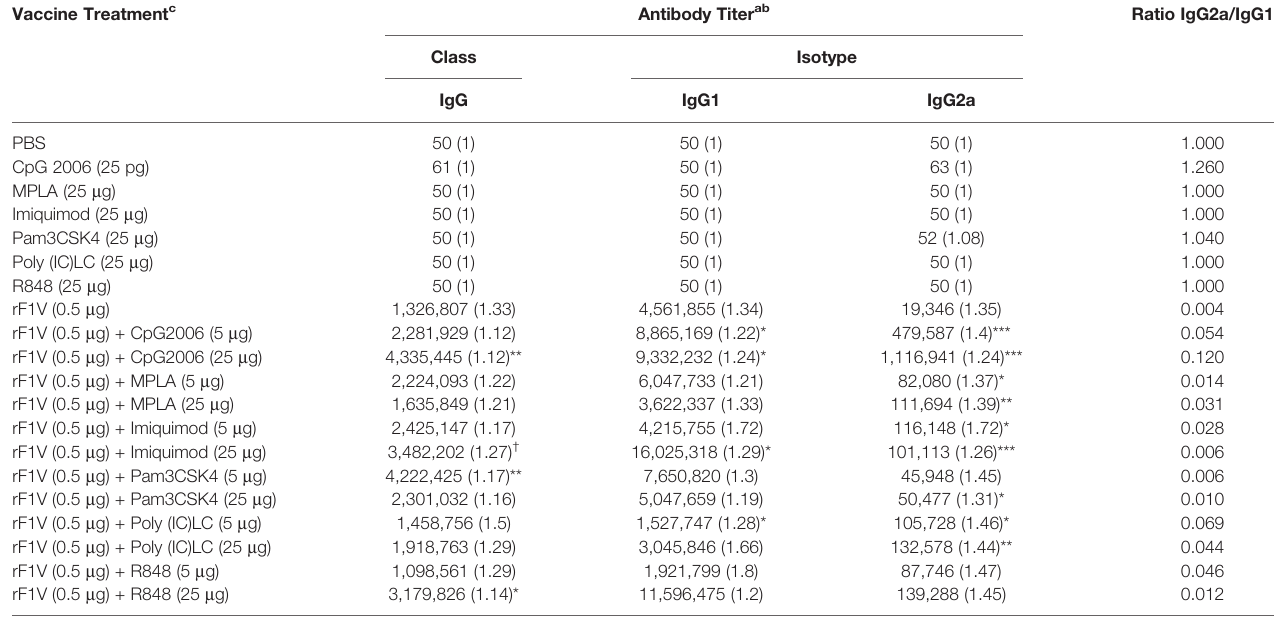
TABLE 3 | Effect of Pam3CSK4 (TLR2), Poly(IC)LC (TLR3), MPLA (TLR4), Imiquimod (TLR7), R848 (TLR7/8) and CpG (TLR9) with rF1V vaccine on the F1V antibody response in BALB/c